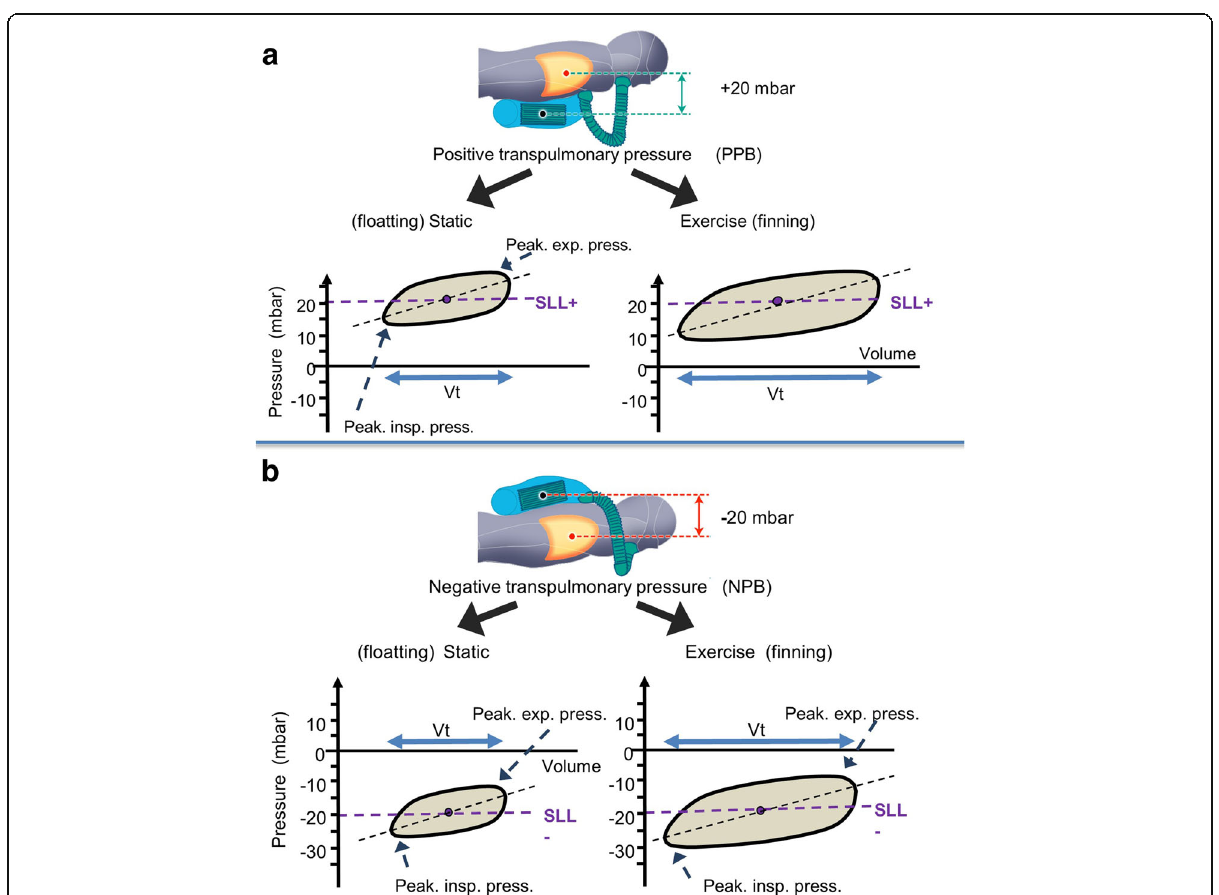
Fig. 1 Tidal volume loop during each dive condition in one diver. A positive transpulmonary pressure gradient (or positive static lung load: SLL+) is set when the rebreather is worn anteriorly (on the abdomen) by the diver in prone position ( a ). A positive pressure breathing (PPB) condition is created. Conversely, when the rebreather is worn posteriorly ( b ), the transpulmonary pressure gradient is negative in the prone position (negative static lung load, SLL − ), and the diver is in condition of negative pressure breathing (NPB). In each condition, the diver completed two 30-min dives, one simply statically floating (static), and one with continuous fin swimming (exercise). Examples of tidal pressure-volume loops are sketched during both static and exercise in each PPB and NPB condition. The dashed lines indicate the SLL level in each condition. Peak insp. press., peak inspiratory pressure during; peak expir. press., peak expiratory pressure. Of note, in each PPB and NPB, Vt lengthening carried the main rest to exercise change, while pressure ranges were very similar during static and exercise